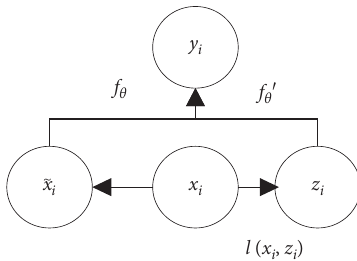
Figure 1: Structure of denoising sparse autoencoder